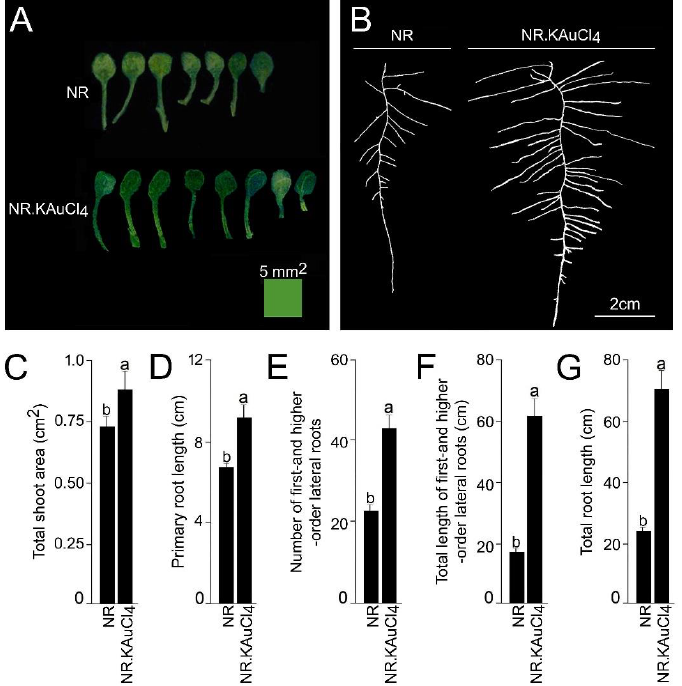
Figure 3. A low dosage of KAuCl 4 triggered augmented developmental responses of the shoot and root. Wild-type Arabidopsis seedlings were initially grown hydroponically in the NR medium for 7 d and then transferred to the NR medium (control) and NR medium supplemented with 10 ppm KAuCl 4 (NR.KAuCl 4 ) and grown for a further 7 d. The seedlings were removed from the hydroponic system, and then ( A ) shoots and ( B ) roots were separated under the stereomicroscope and spread on an agar plate (1.0%; w / v ) to document their phenotype and quantification of different traits. ( C – G ) Data are presented for ( C ) total shoot area, ( D ) primary root length, ( E ) the number of first- and higher-order lateral roots, ( F ) total length of first- and higher-order lateral roots, and ( G ) total root length. Values ( C – G ) are means ± SE ( n = 12) and different letters on the histograms indicate significant differences ( p < 0.05).